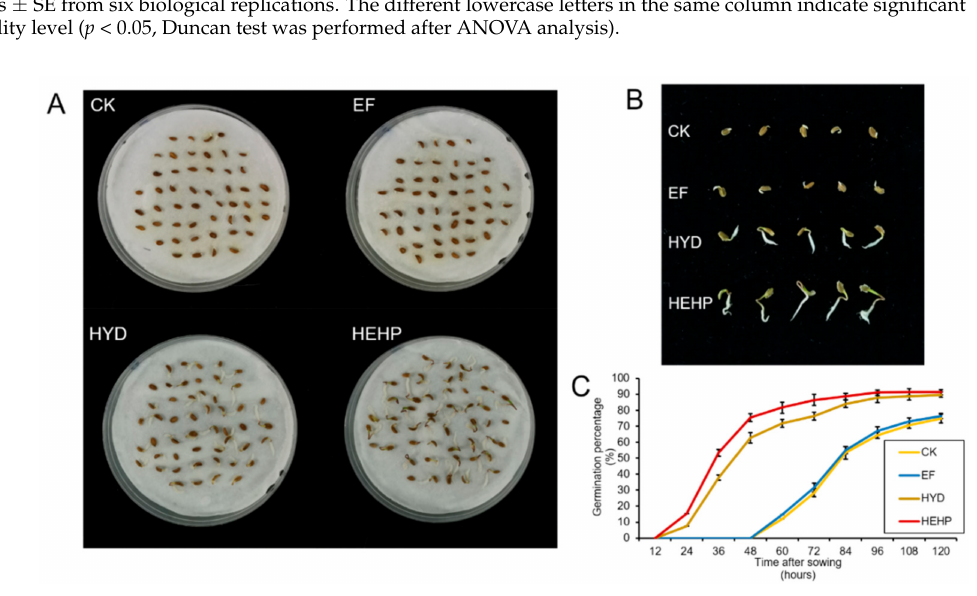
Figure 1. Seed germination and seedling growth status of carrot seeds after different priming treatments. (CK, the control; EF, high-voltage electrostatic field treatment; HYD, hydro-priming treatment; HEHP, hydro-electro hybrid priming treatment) ( A ) Photograph of seed germination experiment at 120 h after sowing; ( B ) Seedlings randomly selected from each treatment at 120 h after sowing; ( C ) Change trend of germination percentage with time after